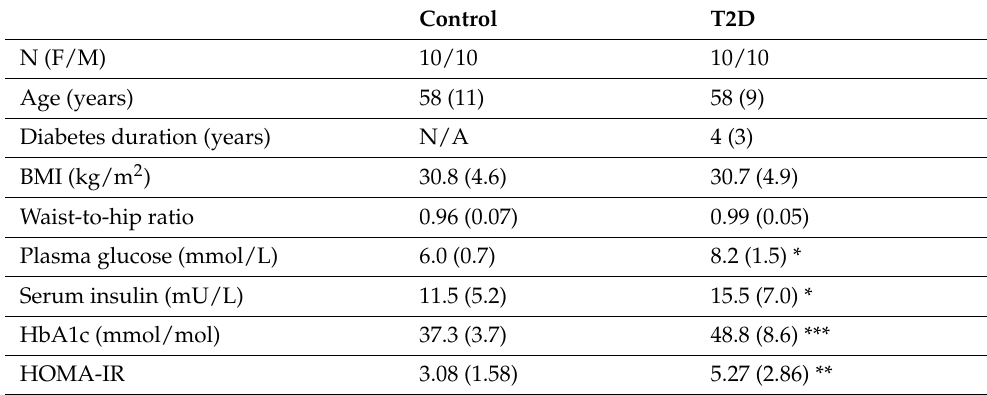
Table 1. Clinical characteristics of study